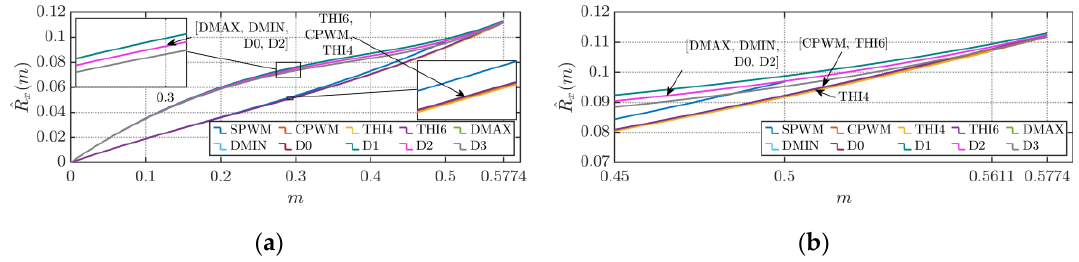
Figure 24. ( a ) Normalized current ripple rms as a function of m for all the considered injections. ( b ) Magnification for high values of m . The normalization base V dc /(2 Lf sw ) has been used.